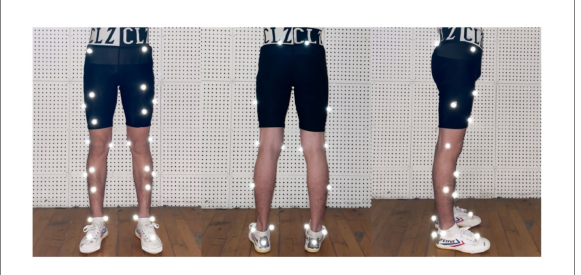
FIGURE 1 Marker sticking